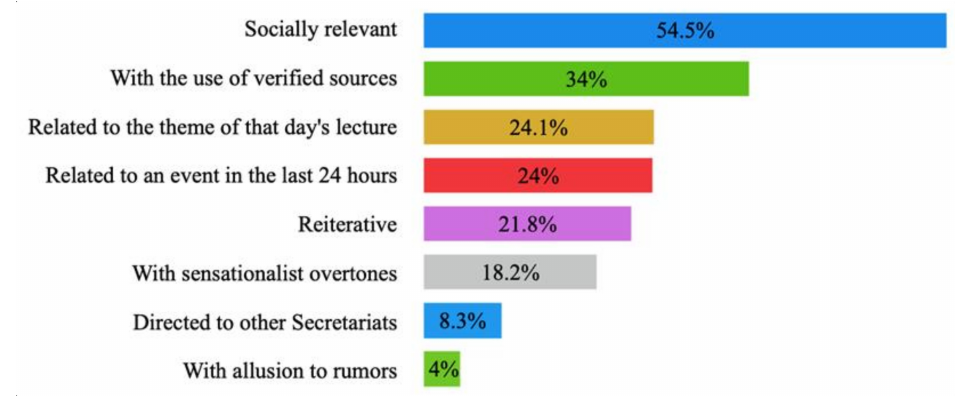
Figure 3. Percentage distribution of the characteristics of the journalists’ questions.